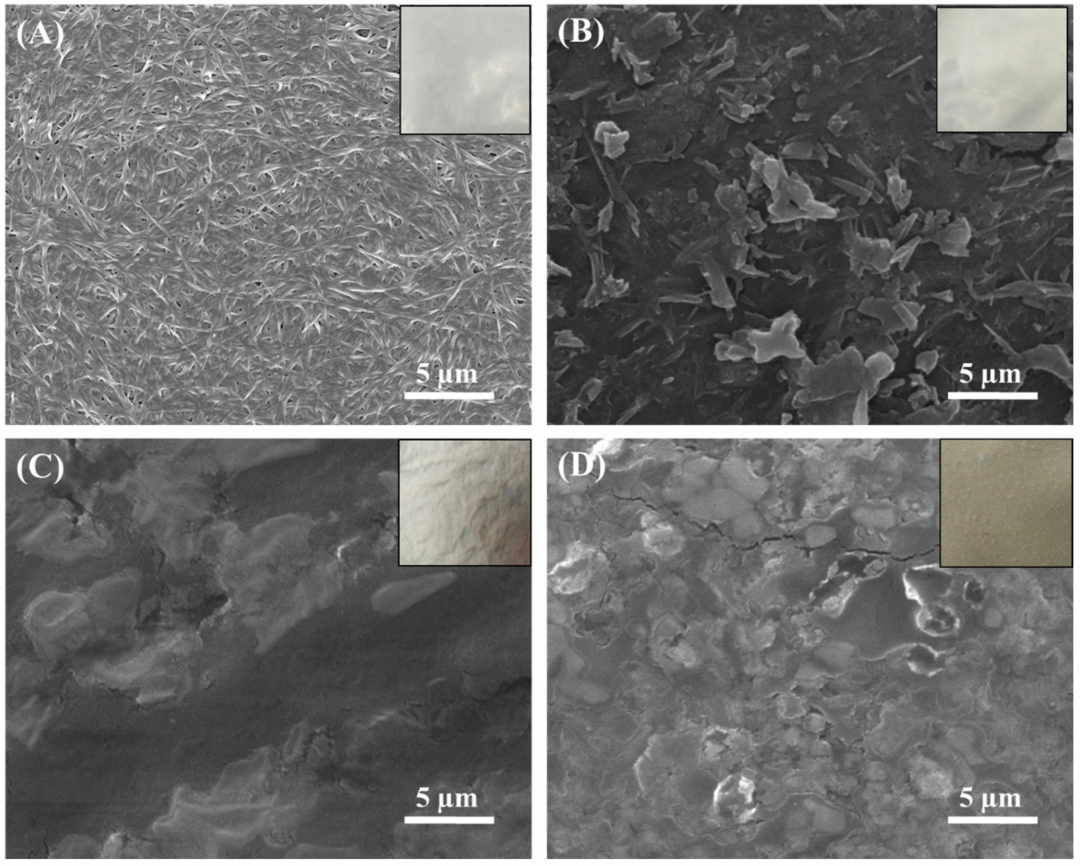
Figure 2. FE-SEM micrographs of surfaces of ( A ) pristine BC, ( B ) BC/CMC, ( C ) BC/CMC/Gly, and ( D ) BC/CMC/Gly/yeast films. The inset images show the respective freeze-dried